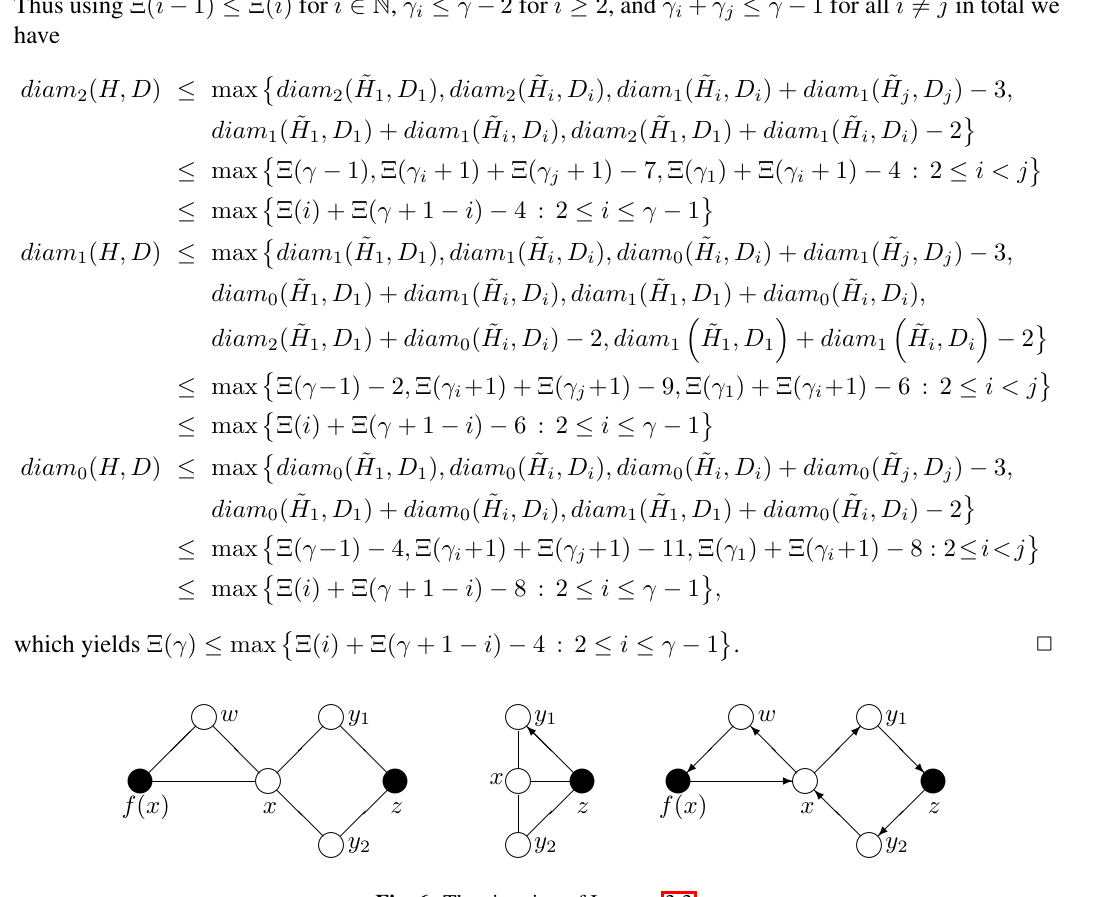
Fig. 6: The situation of Lemma